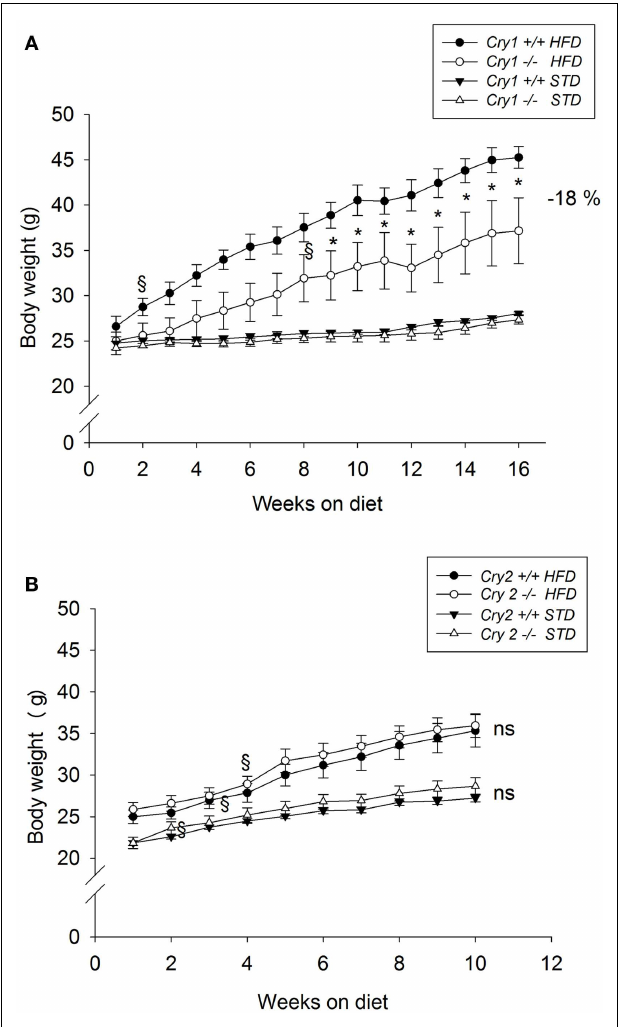
FIGURE 1 | Growth curves ofWT control, Cry1-, and Cry2-deficient mice under STD and HFD . Body weight for age-matched controls (A) : Cry1 + / + (filled symbols) and Cry1 − / − (open symbols) mice, (B) : Cry2 + / + (filled symbols) and Cry2 − / − mice (open symbols), determined once a week, on STD (triangles) and HFD (circles) regimens. Cry1 group: n = 5 ( Cry1 + / + -STD) and 5 ( Cry1 − / − -STD) and n = 4 ( Cry1 + / + -HFD) and 5 ( Cry1 − / − -HFD); Cry2 group: n = 6 ( Cry2 + / + -STD) and n = 7 ( Cry2 − / − -STD), and n = 8 ( Cry2 + / + -HFD) and n = 6 ( Cry2 − / − -STD). * P < 0.05, ns P > 0.05 indicated for genotype comparison, two-way ANOVA for body weight with repeated measures on factor week. § P < 0.05, one-way ANOVA followed by Dunnett’s test for comparison with week 1 with repeated measures for parameter weight.Values shown are mean ± SEM. SUSCEPTIBILITY OF CRY2 − / − MICE TO HIGH-FAT-INDUCED OBESITY Growth and body temperature ( Cry2 + / + -STD: 37.2 ± 0.2°C; Cry2 − / − -STD: 37.4 ± 0.2°C).